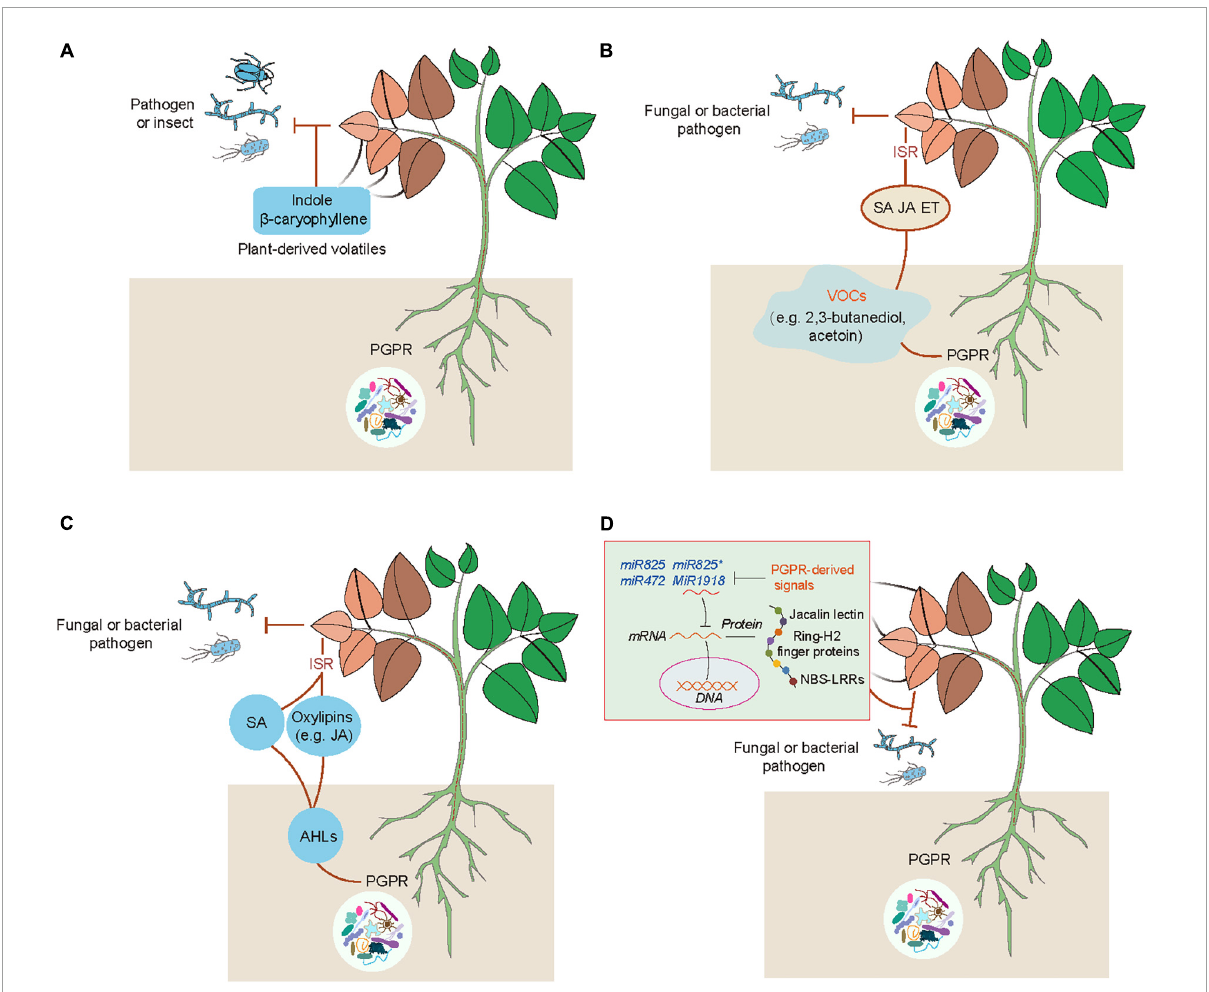
FIGURE2 Multiple acting models of PGPR-induced ISR in plants. (A) PGPR-induced releases of plant volatiles act as defense-related substances against biotic stress. PGPR can induce the emission of plant volatiles such as indole and β -caryophyllene that enhance plant defense against the attacks of pathogens and insect pests. (B) PGPR can emit various kinds of VOCs such as 2,3-butanediol and acetoin, which lead to activation of hormone (SA, ET, and/or JA) signaling pathways that provoke plant ISR against pathogens. (C) PGPR can secrete the QS molecules (N-acyl-homoserine lactones, AHLs) to activate the SA- and JA-mediated pathways, MAPK cascades, and oxylipin-induced defense responses (e.g., promotion of stomatal closure, and the increased accumulation of callose, lignin, ROS and phenolic compounds). These effects lead to the enhanced plant defense against pathogens. (D) Suppression of plant miRNAs by PGPR enhances plant defense against pathogenic attacks. PGPR can release certain signals to repress negative regulators of plant defense systems such as miRNA825/miRNA825*, miR472 and miR1918, and thus enhance the expression of defense-related genes associated with jacalin lectin, Ring-H2 finger gene, and NBS-LRRs, which contribute to the increased resistance of plants against